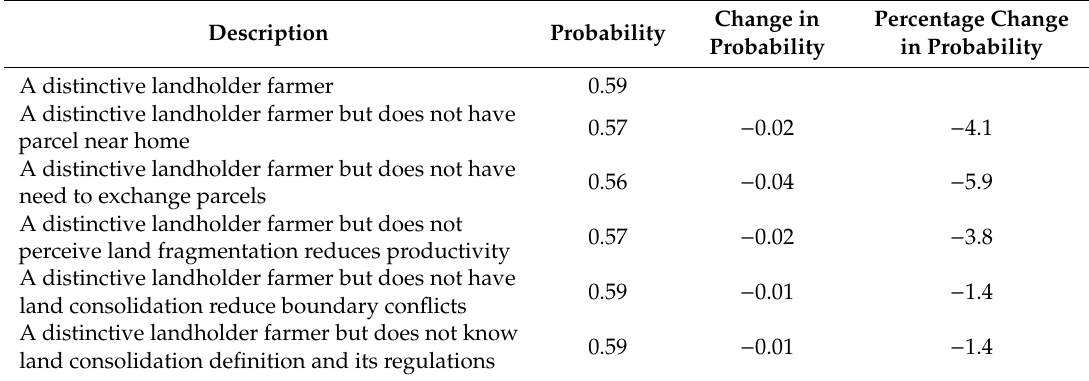
Table 6. Change in probability as a result of a change in significant explanatory